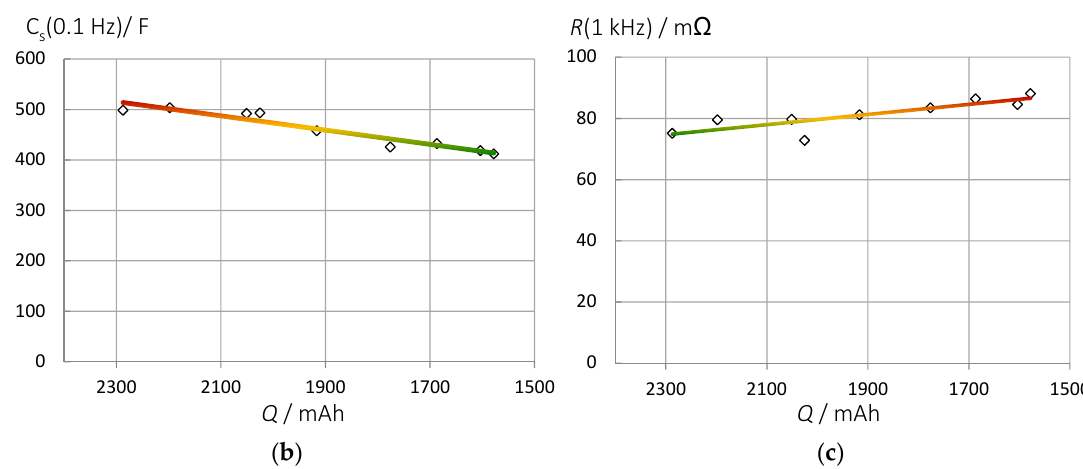
Figure 10. Aging of an LCO battery at the same state-of-charge (Panasonic UR18650 FK). ( a ) Impedance spectra of fully charged batteries during aging by a thousand charge-discharge cycles. ( b ) Pseudocapacitance correlates linearly with the actual battery capacity determined by Ah counting: C = 141 · Q + 191. Fit quality 0.92. ( c ) Increase of electrolyte resistance in time.